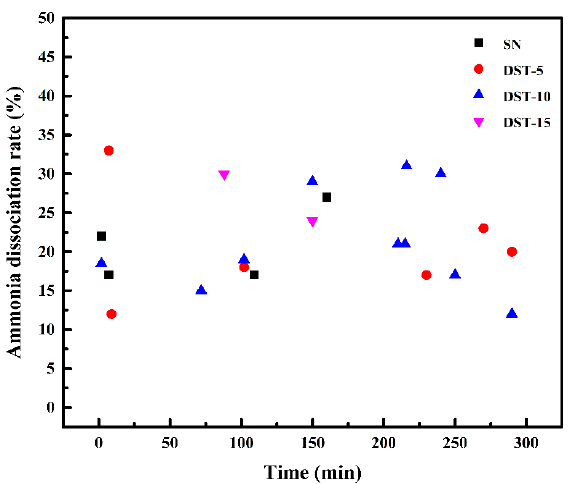
Figure 6. The variation in ammonia dissociation rate of the SN sample and DST samples as a function of nitriding time.